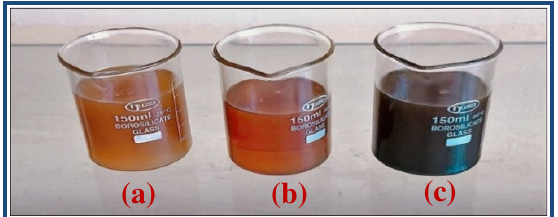
Fig. 4. The stability condition of nano lubricants after 60 days (a) TiO 2 /oil (b) base oil, and (c) CuO NPs.